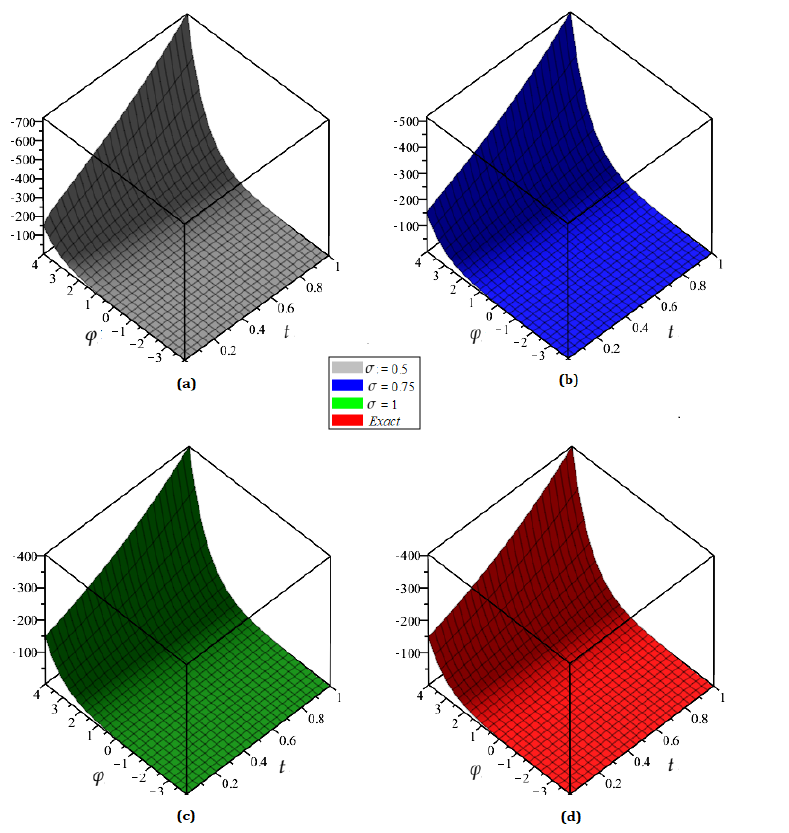
Figure 3. Three-dimensional plots of LRPSM solutions for v ( ϕ , ξ , t ) at distinct values of σ at ξ = 1.